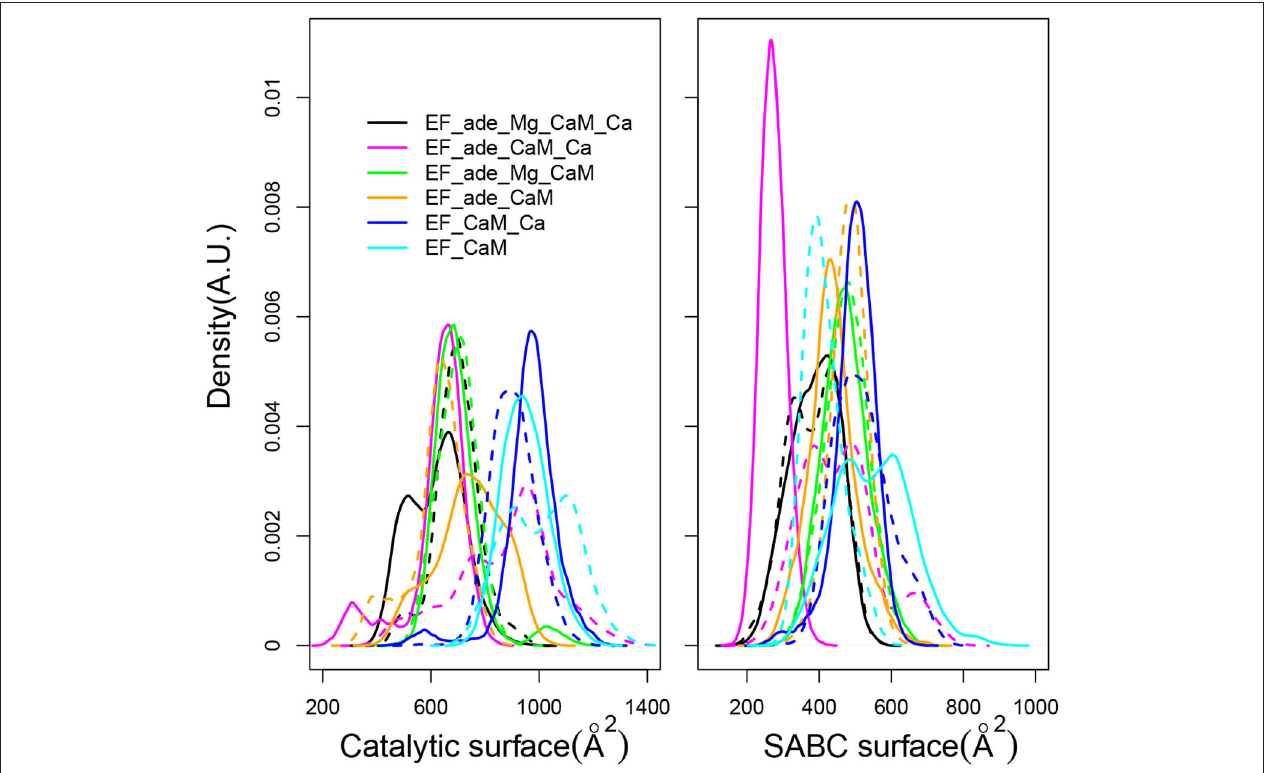
FIGURE 7 | (Left) Distribution of accessible catalytic surface (Å 2 ) of EF, calculated as the sum of the accessible surfaces of residues H351, K353, S354, K372, R329, K346, L348, D491, D493, H577, G578, T579, D582, N583, E588, F586, T548 of EF. (Right) Distribution of accessible surface (Å 2 ) of the pocket SABC, calculated as the sum of the accessible surfaces of residues A496, P499, I538, E539, P542, S544, S550, W552, Q553, T579, Q581, L625, Y626, Y627, N629, and N709 of EF. For each trajectory, the plain and dashed curves correspond to replicas R1 and R2.